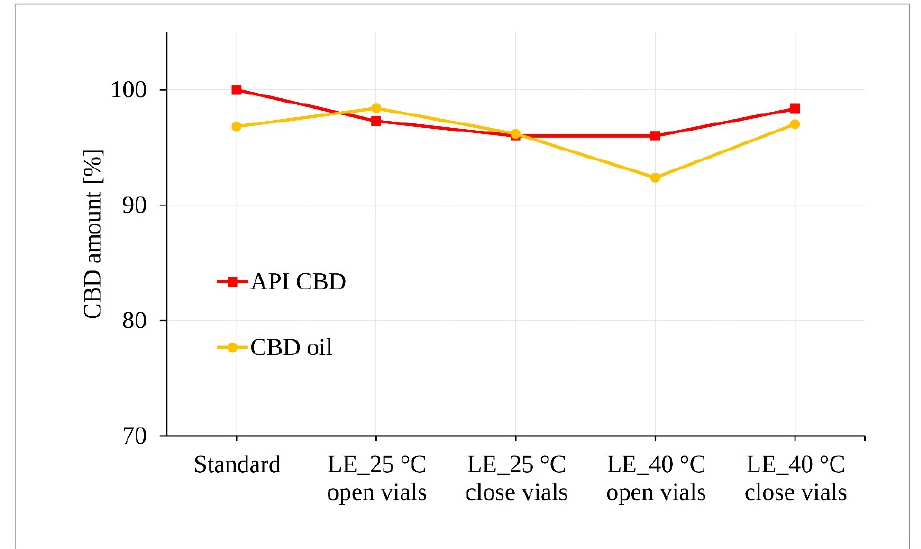
Figure 6. Photostability of the CBD samples measured by LC-UV. (LE, light exposure).